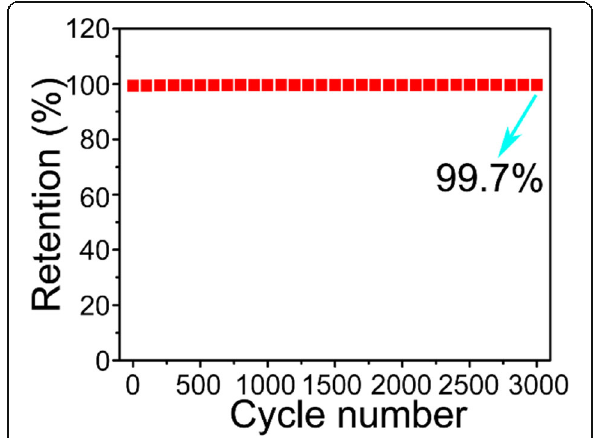
Fig. 4 Cycling stability of the CF@MnO 2 NWA electrode for 3000 cycles at a scan rate of 50 mV s −